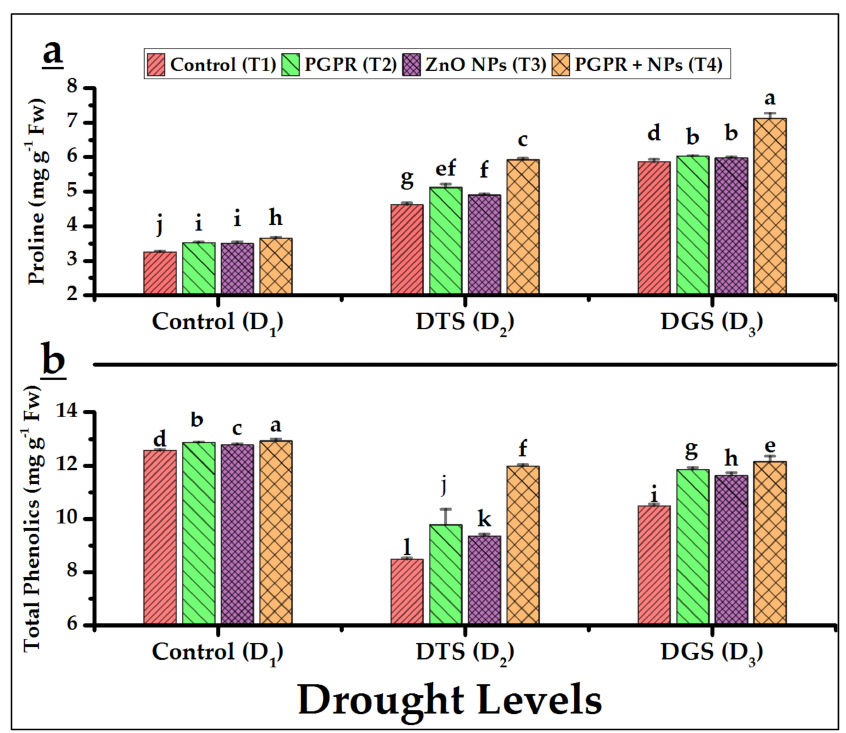
Figure 5. Effects of PGPR and ZnO NPs on foliar proline ( a ) and total phenolics ( b ) in drought- stressed wheat. DTS = drought at tillering, DGS = drought at grain filling, T 1 = control, T 2 = single use of Azospirillum brasilense , T 3 = single use of ZnO NPs, and T 4 = co-application of PGPR and NPs. Error bars indicates standard error ( n = 3). (Note: Different lowercase letters indicate significant differences between different drought levels and treatments by the LSD test at p <